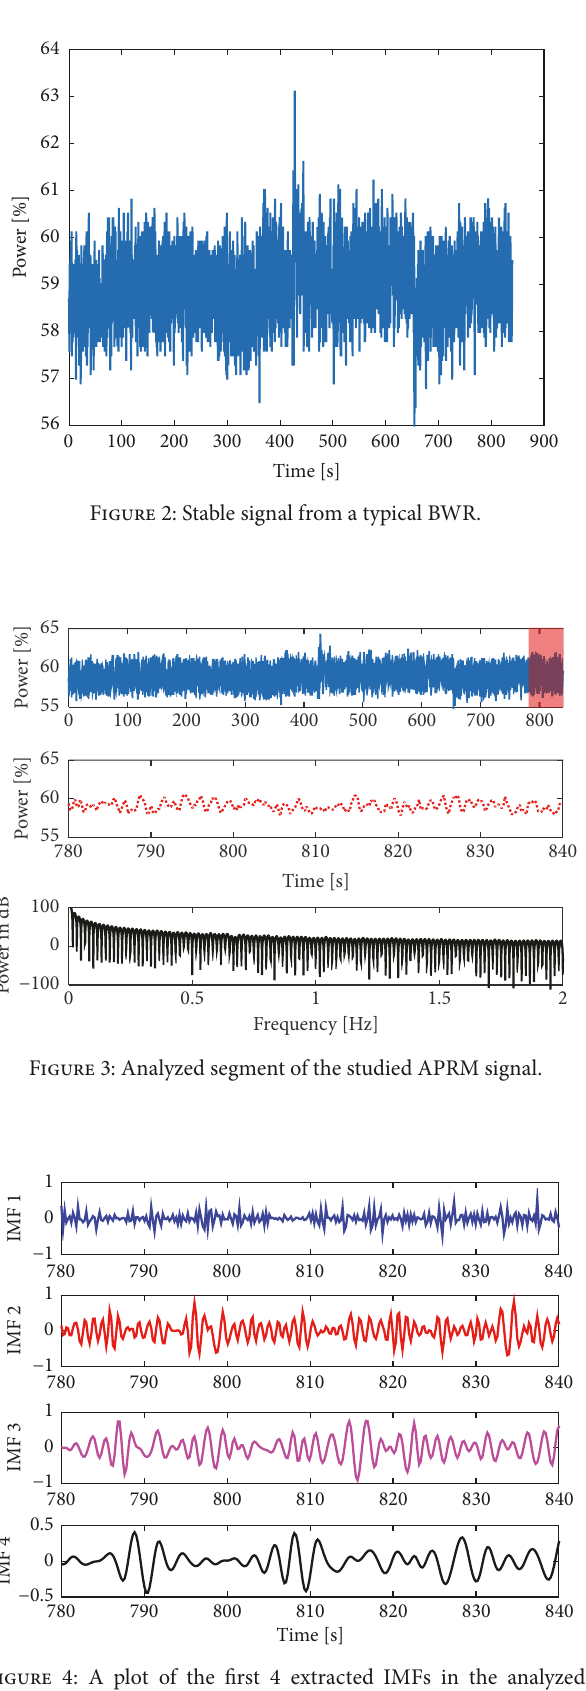
Figure 4: A plot of the first 4 extracted IMFs in the analyzed segment.